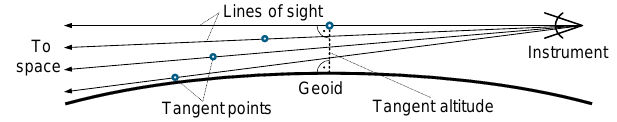
Figure 1. The viewing geometry of a limb sounder (Ungermann et al.,